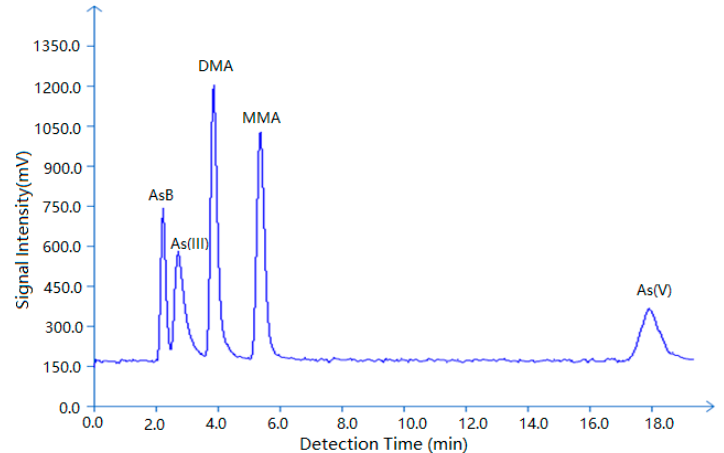
Figure 1. The detection time and signal intensity for arsenic species in standard reference material (80 µ g/L AsB, As(III), DMA, MMA, and As(V) mix solution).